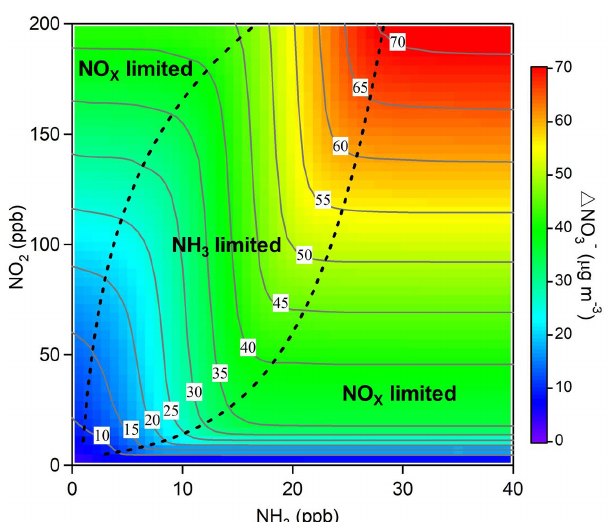
Figure 8. Contour plot of the model-simulated daytime NO − mation as a function of the initial concentrations of NO 2 (0– 200ppbv) and NH 3 (0–40ppbv). Note that the dashed lines are arti- ficially drawn to separate the three zones with a different sensitivity of nitrate formation to NO 2 and NH 3